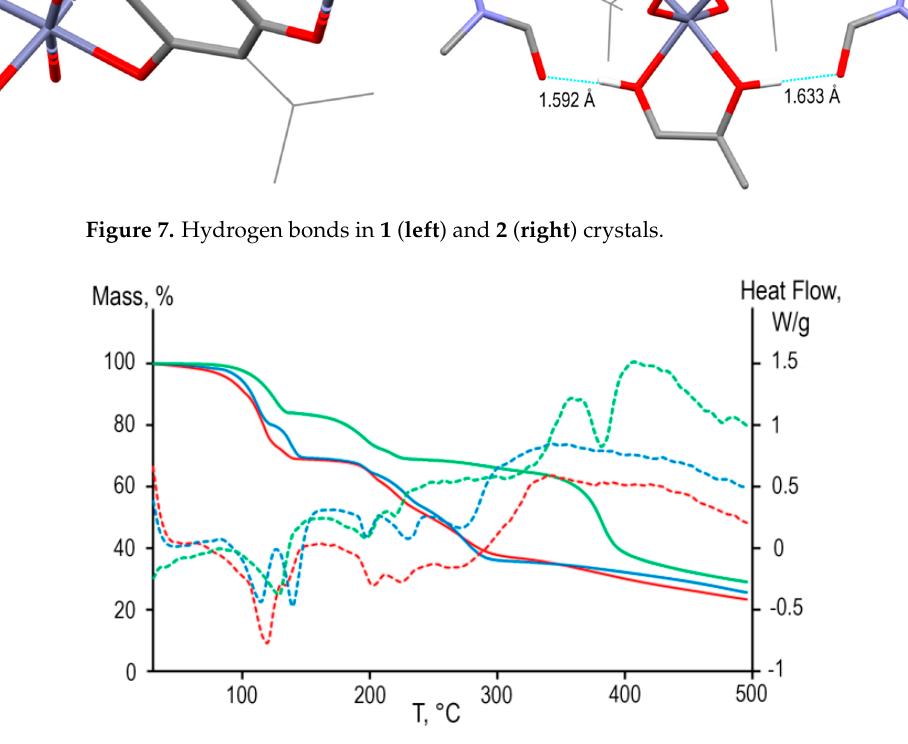
Figure 8. TG curves for 1 (red line), 2 (blue line), and 3 (green line). DTA curves are shown with dashed lines.